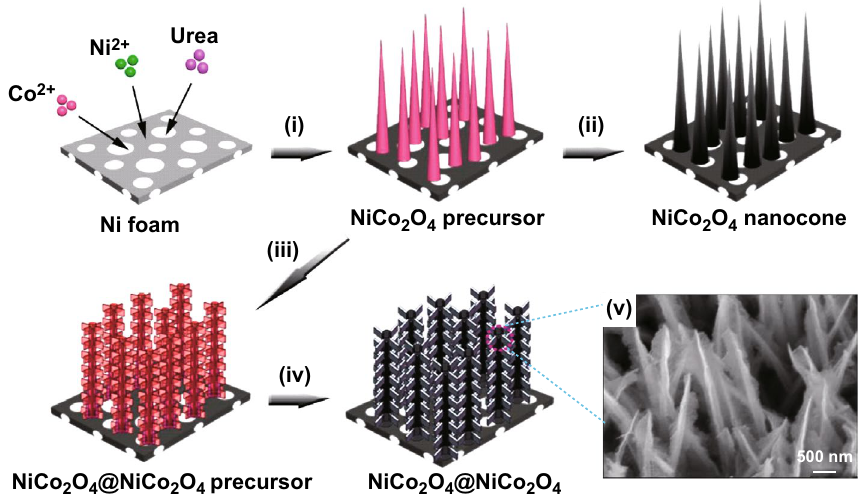
Fig. 8 Schematic illustration for the formation of highly ordered 3D hierarchical NiCo 2 O 4 @NiCo 2 O 4 core–shell nanocones arrays on nickel foams. Reproduced with permission from Ref. [123], Copyright © 2018 Elsevier